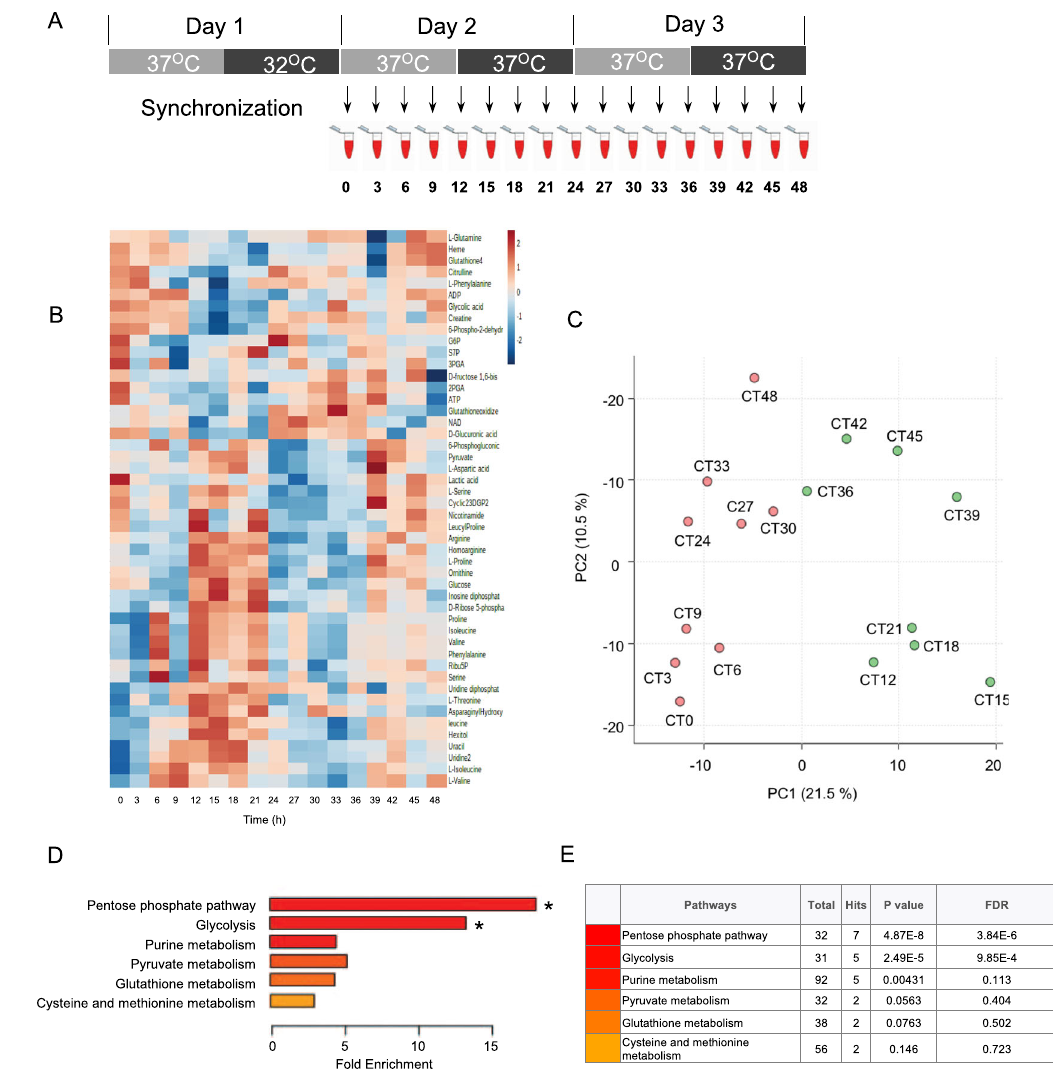
Fig. 1 Redox and metabolic rhythms in human red blood cells (RBCs). A Experimental scheme for untargeted Human RBCs circadian sampling. RBCs from n = 3 – 4 human subjects were incubated with 11 mM glucose and kept under constant conditions (37 °C in continuous darkness) and sampling was performed every 3 h. Untargeted metabolite analysis was performed using GC-MS and LC-MS. B Heatmap of all cycling features ordered by the phase of the oscillation. Features extracted from spectra using Progenesis QI (LC-MS) and MassHunter (GC-MS) were used for the rhythmicity analysis using RAIN algorithm (* P < 0.05, FDR = 0.2). Data are Z -score normalized log10 intensities. C Principal components analysis (PCA) of the cycling metabolome. The two major components separate the data into samples corresponding to the circadian day (left, orange) and night (right, green) time-points. D Pathway analysis performed using Metabolite Set Enrichment Analysis (MSEA) using only identi fi ed 24-h rhythmic metabolites. The color bar represents the signi fi cance level, as shown in the table. *FDR < 0.01. E Table representing the enriched metabolic pathways with the corresponding metabolite hits, P values and